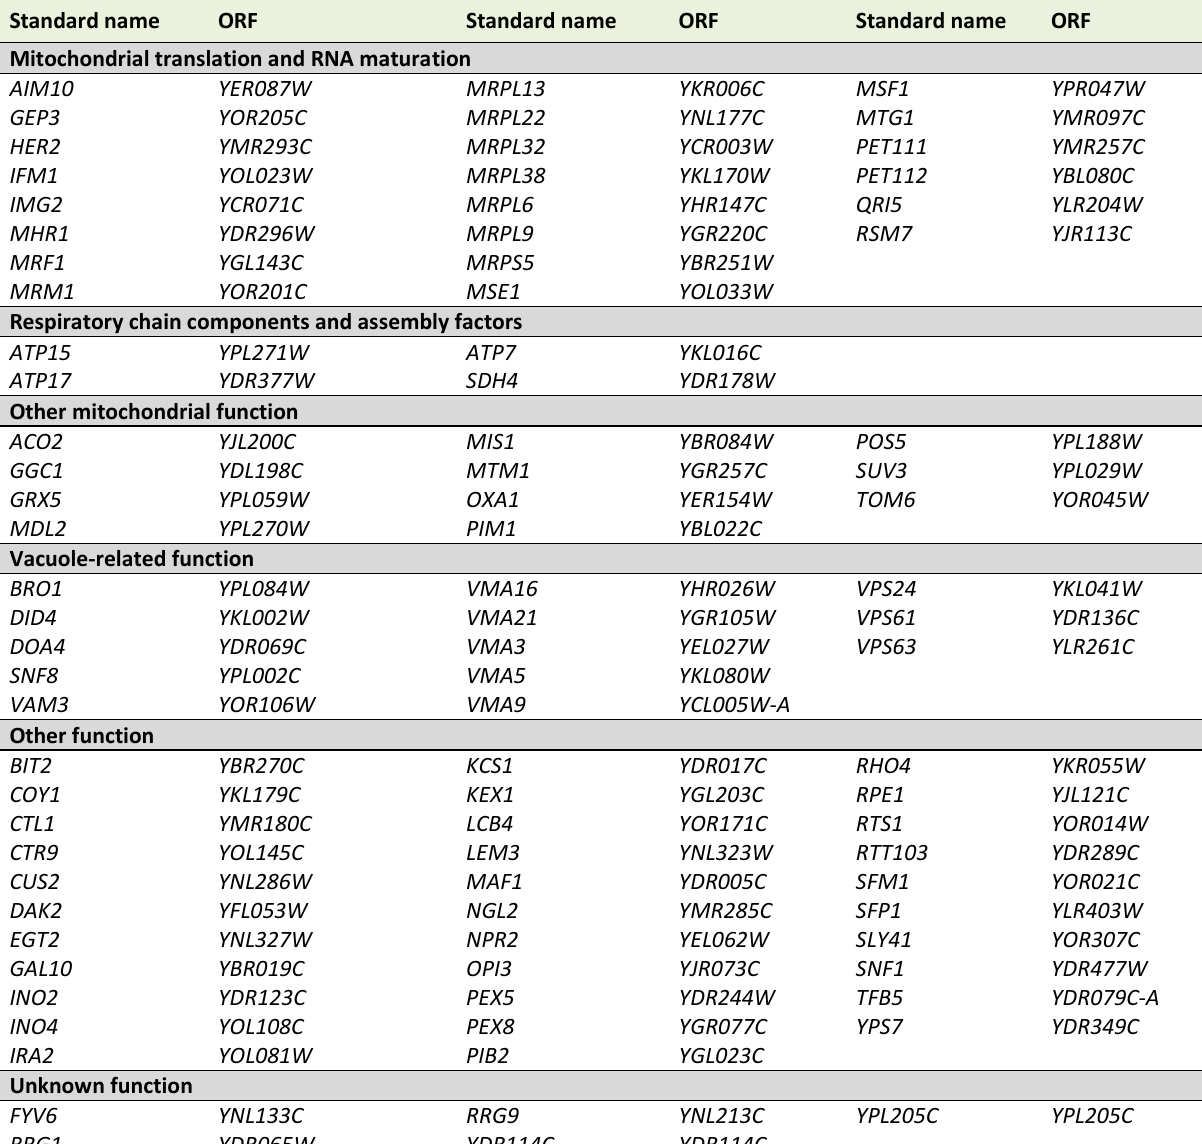
TABLE 3. Genes required for expression of Arg8 m in mitochondria. The yeast deletion collection was treated as outlined in Fig. 3A. This table is an excerpt of Table S5. Genes with known functions in arginine biosynthesis or mating and dubious ORFs were excluded from this list. Genes required for maintenance of [ ARG8 m ] mtDNA are listed in Table